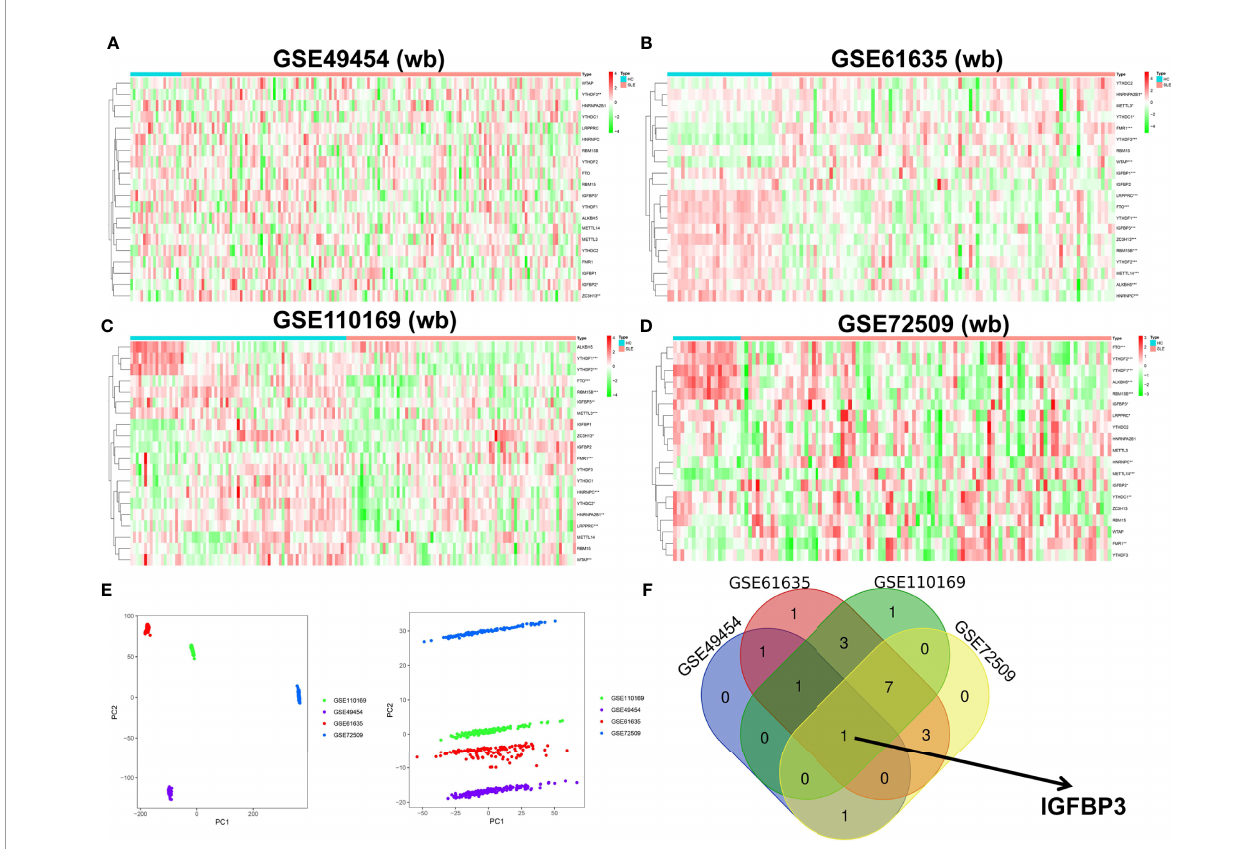
FIGURE 1 | Identi fi cation of the key m6A regulators in the four GEO datasets. (A – C) Heatmap showing the expression status of m6A regulators between SLE and healthy controls in (A) GSE49454, including 4 m6A regulators; (B) GSE61635, including 17 m6A regulators; (C) GSE110169, including 13 m6A regulators; and (D) GSE72509, including 12 m6A regulators. Green: low expression level; red: high expression level. (E) Principal component analysis for the expression of genes to distinguish GEO cohorts of SLE (GSE49454, GSE61635, GSE110169, and GSE72509). (F) Venn diagram to identify m6A regulators between SLE and healthy samples. *p < 0.05, **p < 0.01, ***p <